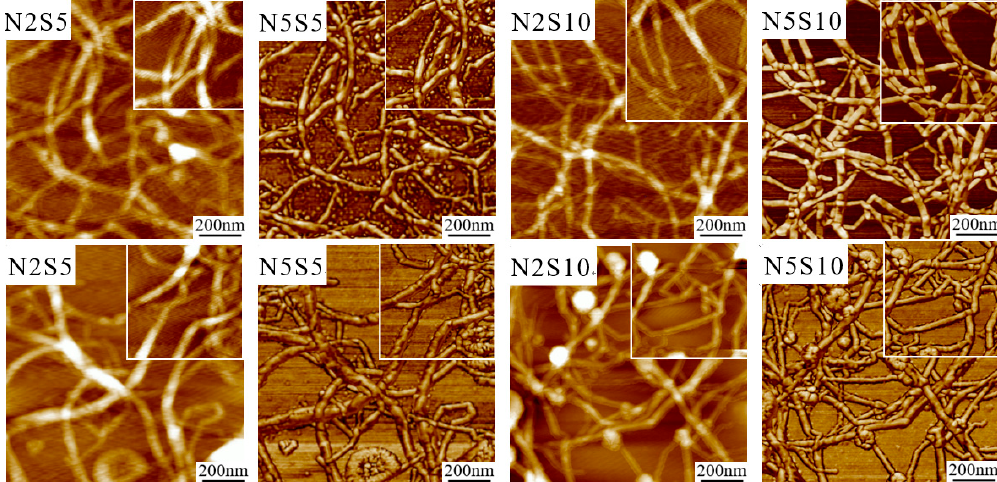
Figure 5. The morphology of PCF cellulose after 2 and 5wt% NaOH treatment with atomic force microscope at different time. (N2S5: 2 wt% NaOH and 5 min sonication, N5S5: 5 wt% NaOH and 5 min sonication N2S10: 2 wt% NaOH and 10 min sonication, N5S10: 5 wt% NaOH and 10 min sonication N2S5 and N2S10 for height map, N5S5 and N5S10 for phase map).